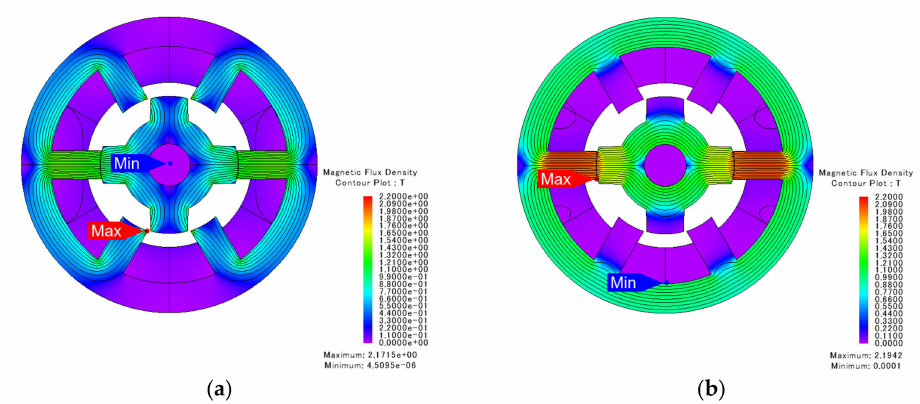
Figure 11. Flux distribution of each winding configuration: ( a ) short-flux path; ( b ) long-flux path.